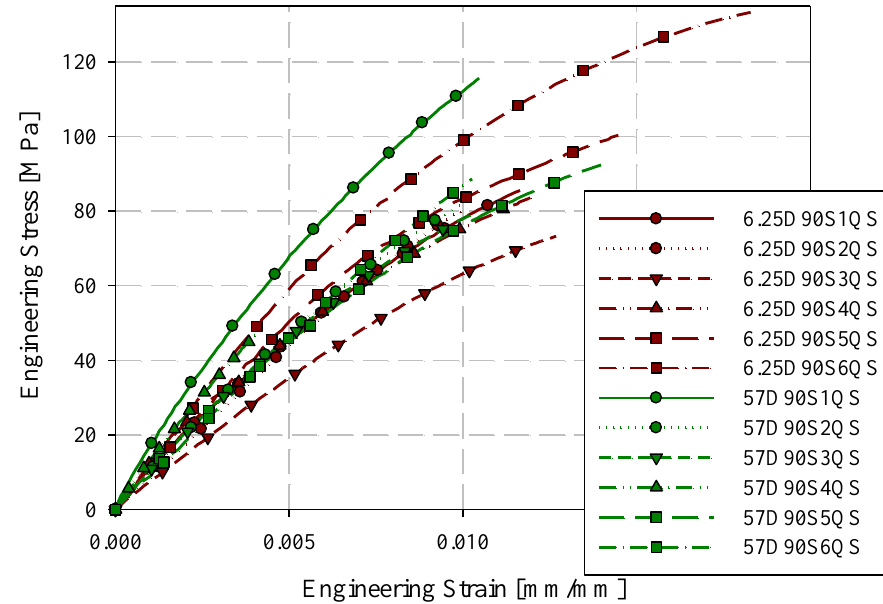
Figure 8. 90-degree quasi-static engineering stress-strain responses ASTM D638 type III and reduced gauge length (6.25 mm) specimens.